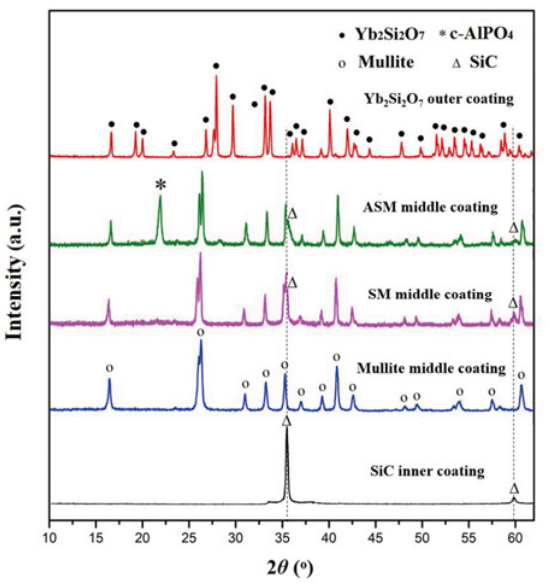
Fig. 2 Surface XRD patterns of different coatings in the tri- layer Yb 2 Si 2 O 7 /mullite/SiC, Yb 2 Si 2 O 7 /SM/SiC, and Yb 2 Si 2 O 7 / ASM/SiC coatings-coated C f /SiC composites.